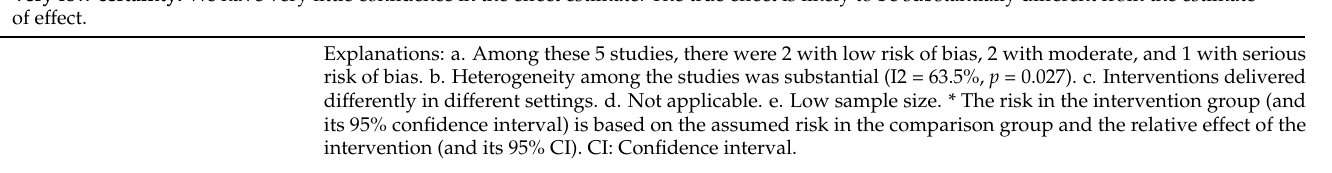
Table 4. GRADE of evidence of our results for visual acuity as a categorical